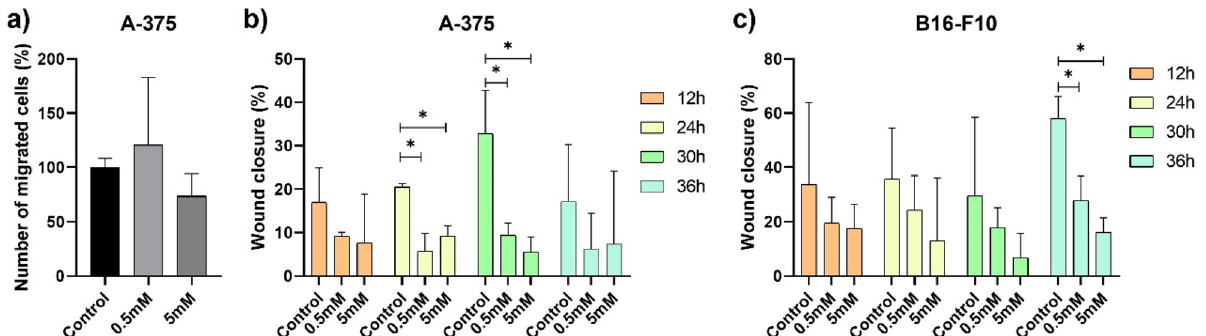
Figure 2. Effects of metformin on cell migration and invasion. ( a ) Number of A-375 invasion cells treated for 24-h with 0.5 mM or 5 mM metformin. ( b , c ) Wound closure percentual of A-375 ( b ) and B16-F10 ( c ) cells treated with 0.5 mM or 5 mM metformin. *p < 0.05 (One-way